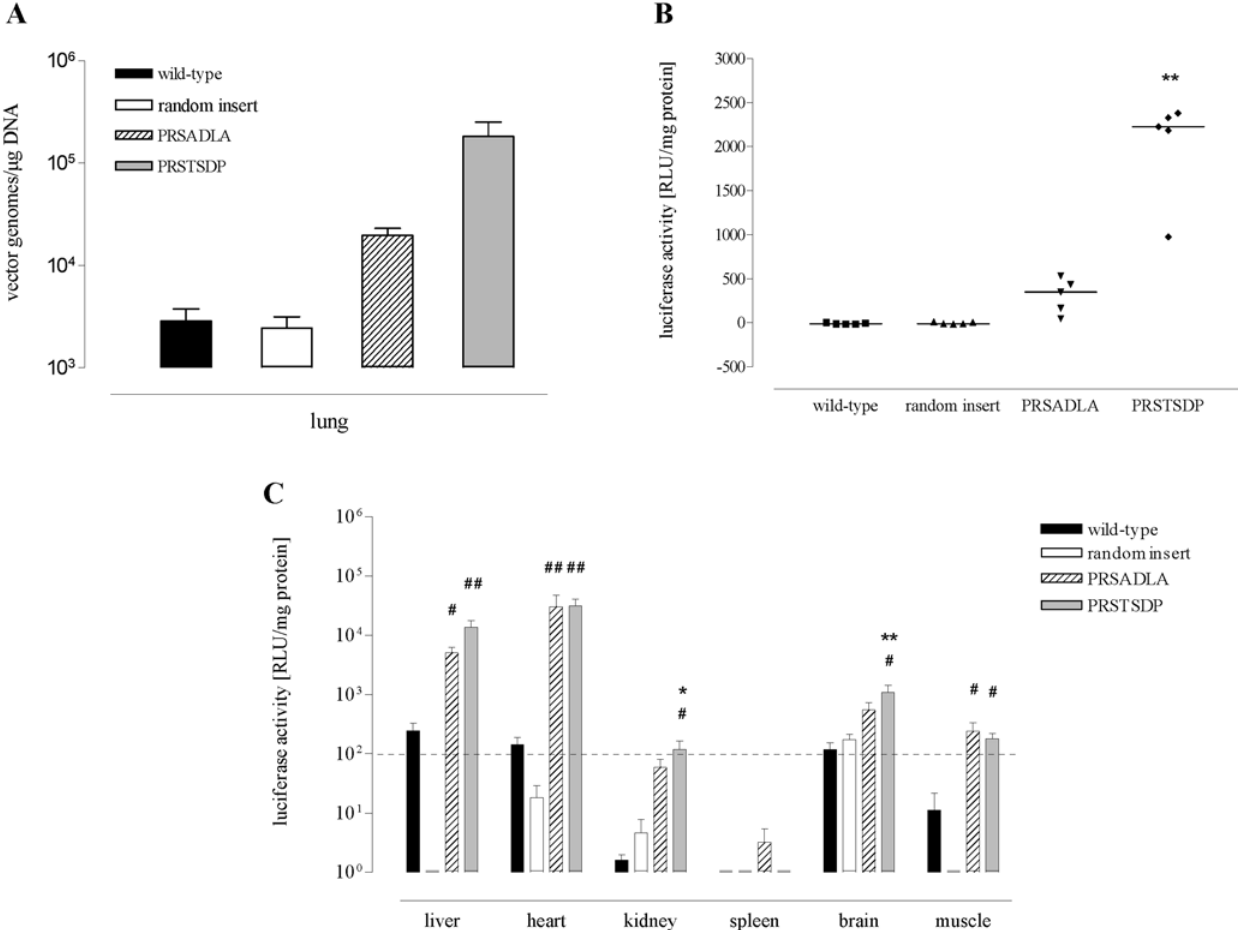
Figure 5. Targeting of AAV capsid mutants selected on murine lung tissue invivo. AAV luciferase vectors displaying selected or control capsids (wild-type or random insert VRRPRFW) were injected intravenously into female FVB mice. Tissue was harvested after 8 or 28 d, respectively, and processed as indicated. A: Evaluation of lung homing. Lung tissue was harvested 8 days after vector injection and the amount of AAV genomes was determined by quantitative PCR. Data represent mean values from n=3 mice per group, analyzed in triplicates 6 SD. B: In vivo lung gene transfer by selected AAV after intravenous injection. Lung tissue was harvested 28 days after vector injection, and luciferase activity was determined as relative light units (RLU) per mg protein. Bars indicate the median value, n=5 mice per group (**=p , 0.001 targeted vectors vs. wild-type and random insert control). C: In vivo transduction of various tissues in mice by AAV library mutants selected for lung transduction. Tissues were harvested and luciferase activity was determined as in 5B. The dotted line indicates the threshold beyond which luciferase expression data could be reliably delineated from background signal. Data represent mean values 6 SEM, n=5 mice per group. * p , 0.05; ** p , 0.01 targeted vectors vs. wild- type AAV-2. # p , 0.05; ## p , 0.01 targeted vectors vs. random insert